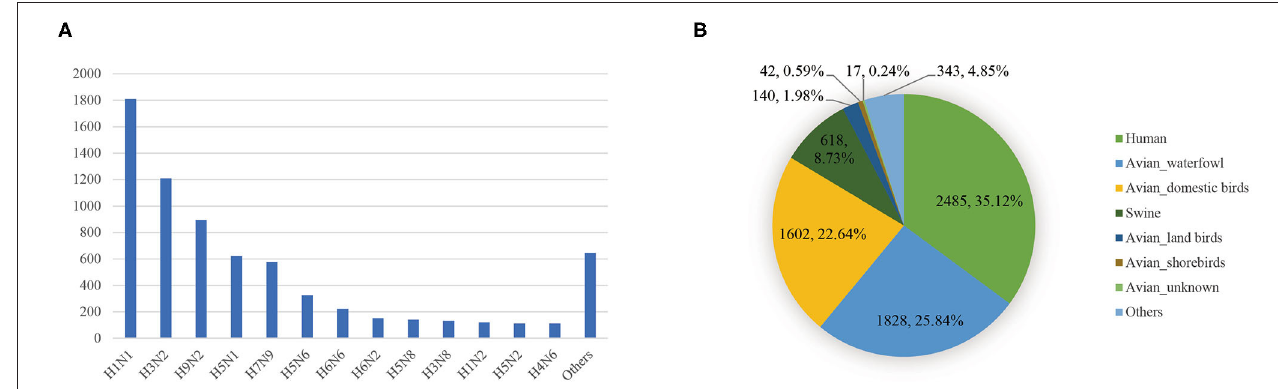
FIGURE 1 | (A) The distribution of the number of viruses in each subtype. (B) The distribution of the number of viruses in each host.